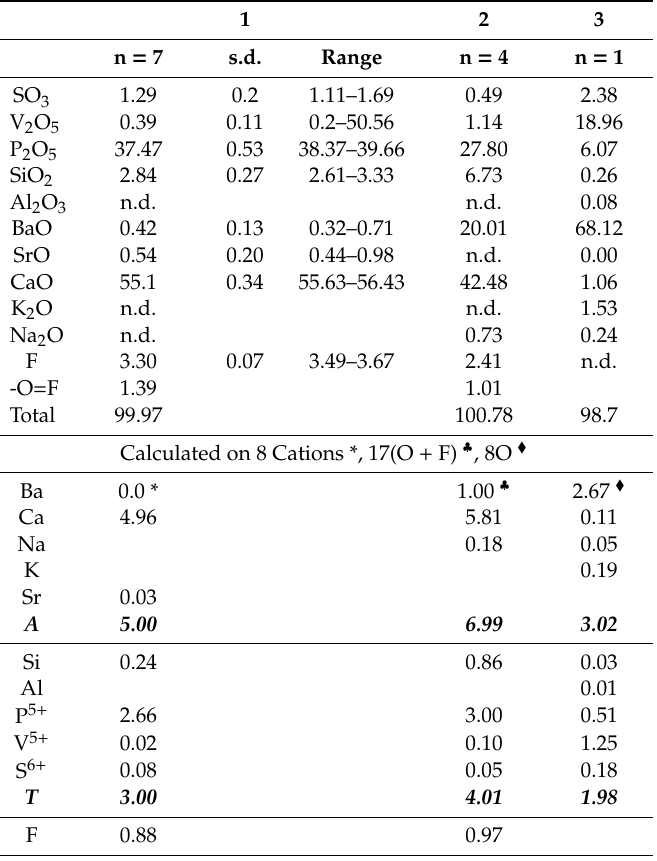
Table 10. Chemical composition of apatite (1, Zuk Tamrur), zadovite (2, Zuk Tamrur) and gurimite (3, Gurim